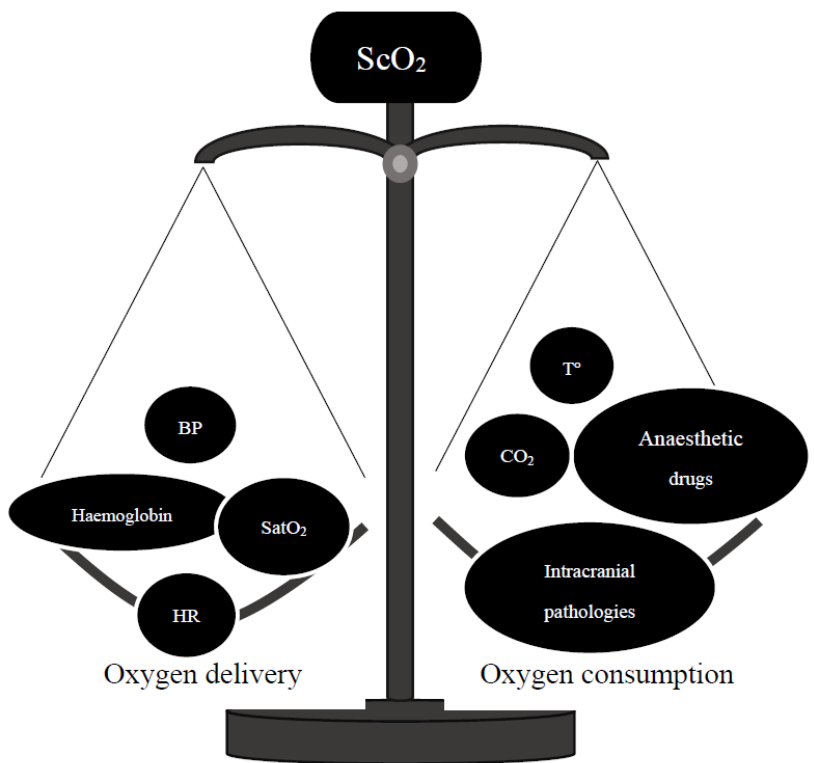
Figure 2. Cerebral oxygen delivery and consumption balance and contributing factors to cerebral oxygen saturation during anaesthesia. HR, heart rate; BP, blood pressure; SatO 2 , oxygen saturation; CO 2 , carbon dioxide; T°, temperature; ScO 2 cerebral oxygen saturation.